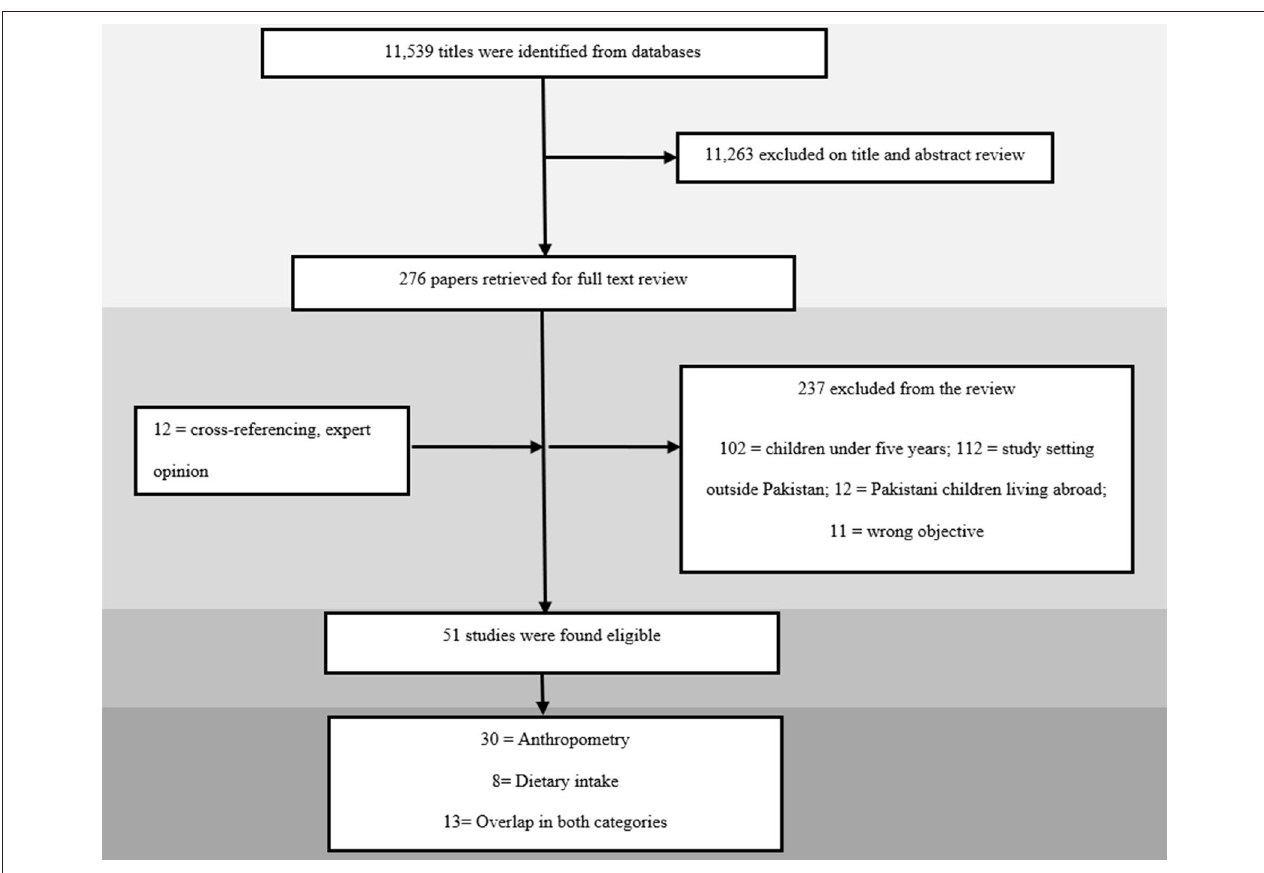
FIGURE 1 | Search flow